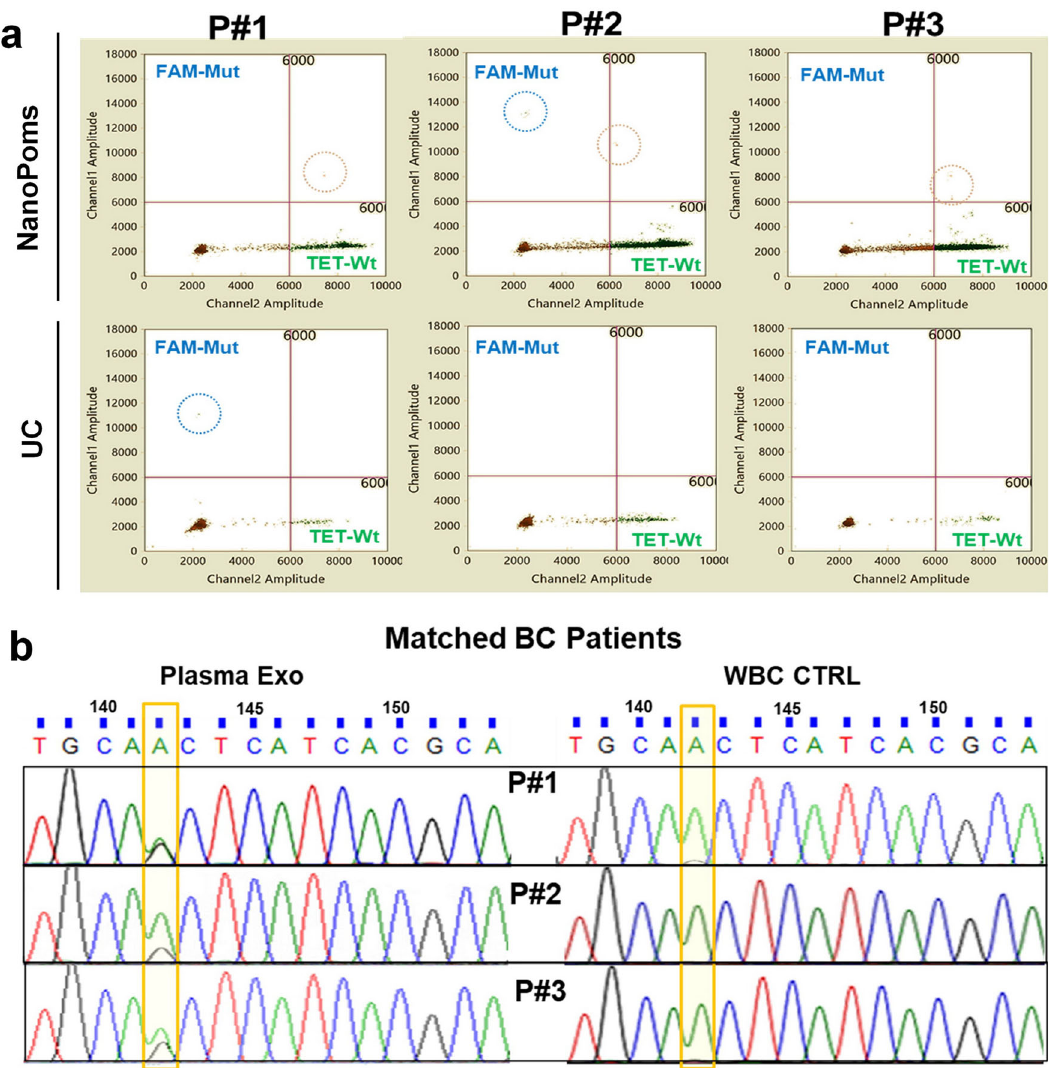
Fig. 3 NanoPoms prepared exosomes enable highly sensitive detection of heterozygosity using ddPCR. a The ddPCR detection of EGFR (Thr790Met) heterozygosity from NanoPoms prepared urinary exosomes in three BC patients, compared with UC preparation. b Sanger sequence validation of EGFR heterozygosity from NanoPoms prepared plasma exosomes from matched patients in Fig. 3a. Genes from the corresponding patients ’ white blood cells (WBC) are the wild-type